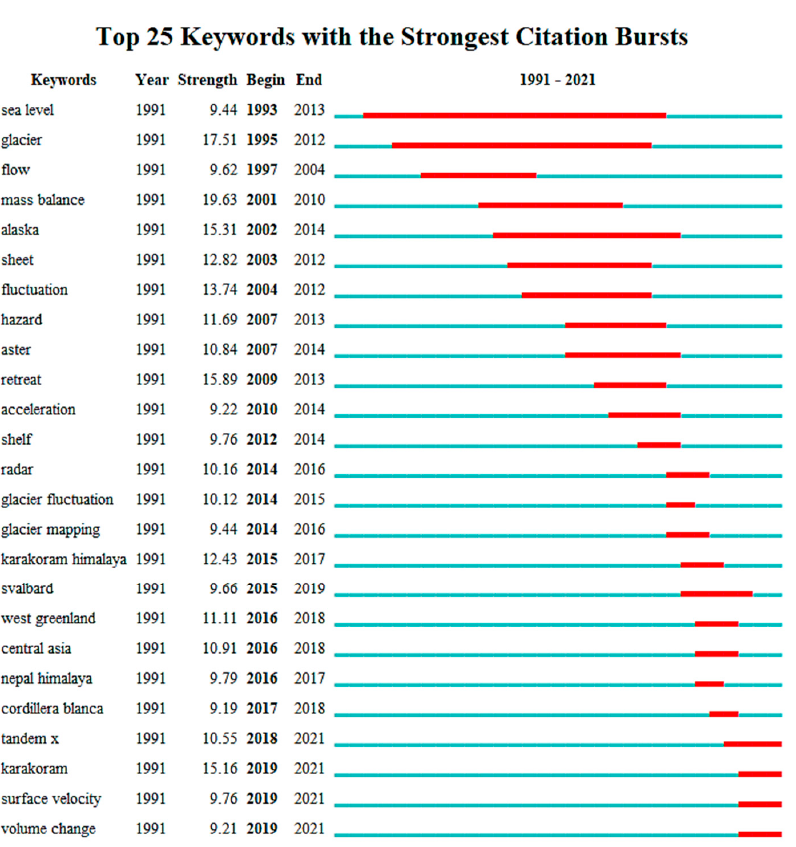
Figure 11. Top 25 burst keywords.